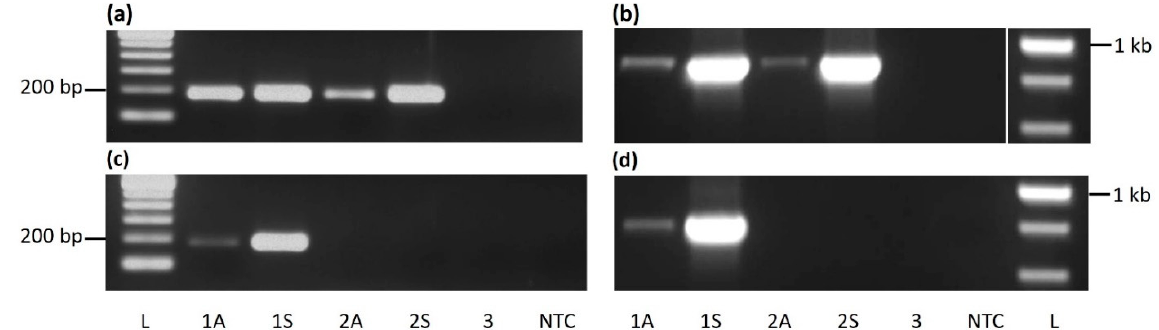
Figure 1. PCR-based detection of cacao mild mosaic virus (CaMMV) and cacao yellow vein-banding virus (CYVBV) in cocoa. A 193 bp ( a ) and a 861 bp ( b ) fragment of CaMMV, and a 183 bp ( c ) and a 802 bp ( d ) fragment of CYVBV targeting RT-RNase H region were amplified from cocoa accessions ICS 27 (1), ICS 76 (2) and RIM 52 (3) received from Trinidad. Letters A or S represents asymptomatic and symptomatic leaves, respectively. NTC stands for no template control and letter L denotes the lane loaded with 100 bp ( a , c ) or 1 Kb ladder ( b , d ).